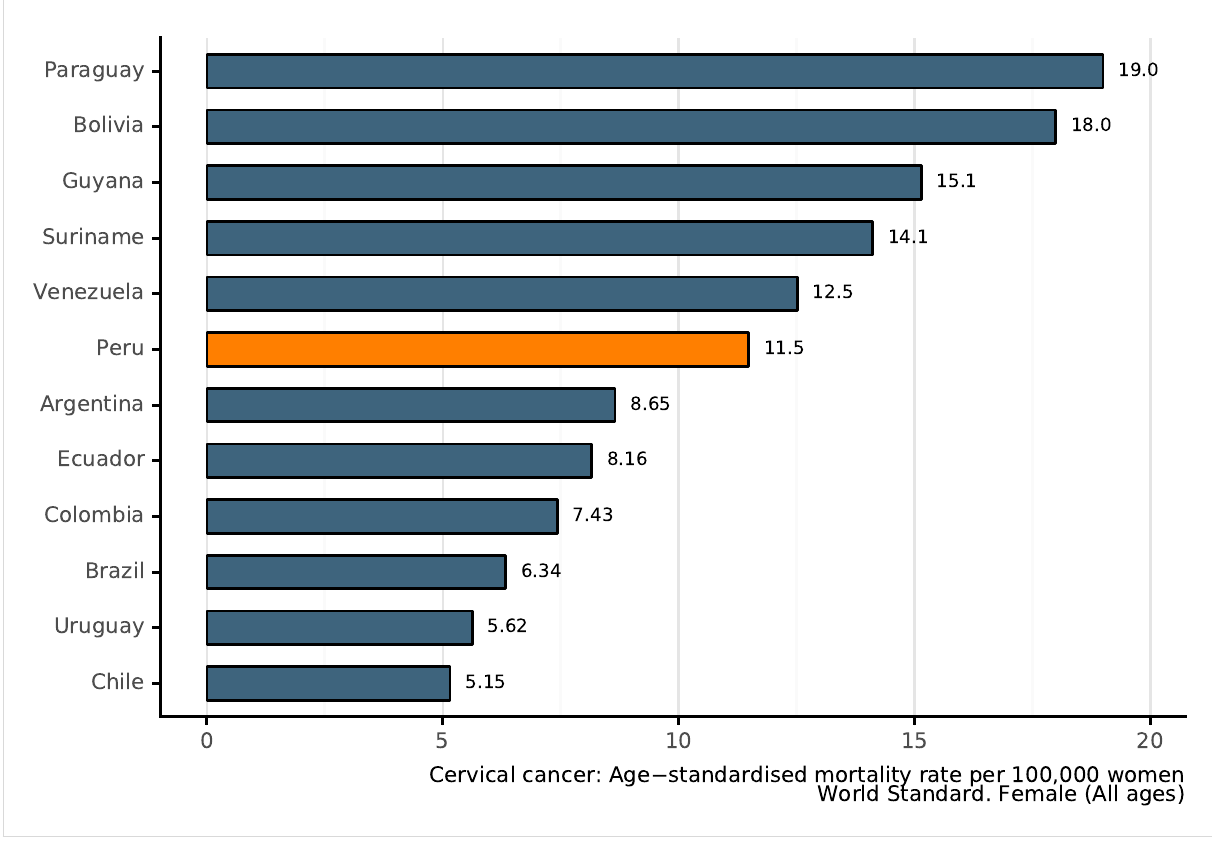
Figure 105: Age-standardised mortality rates of cervical cancer of Peru (estimates for 2020)